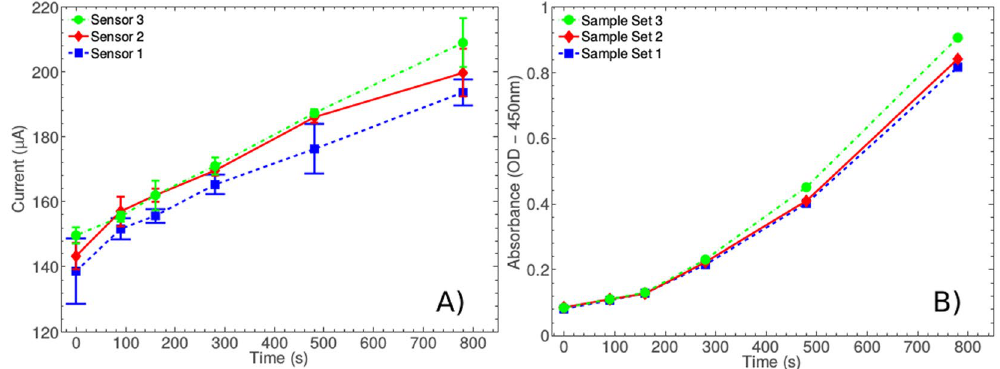
Figure 4. Comparison of amperometric and colorimetric detection of TMB product concentrations. A range of TMB product concentrations were achieved by allowing a range of enzymatic conversion times using a single HRP enzyme concentration. Results were obtained using three different amperometric sensors, however, all colorimetric results were obtained using the same colorimetric quantification apparatus (Promega